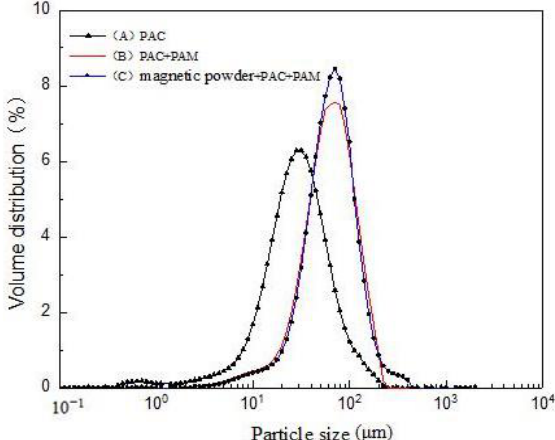
Figure 5. Particle size distribution of